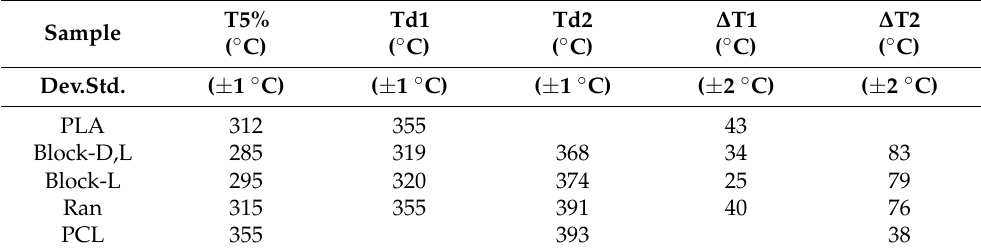
Table 2. TGA results of the analyzed